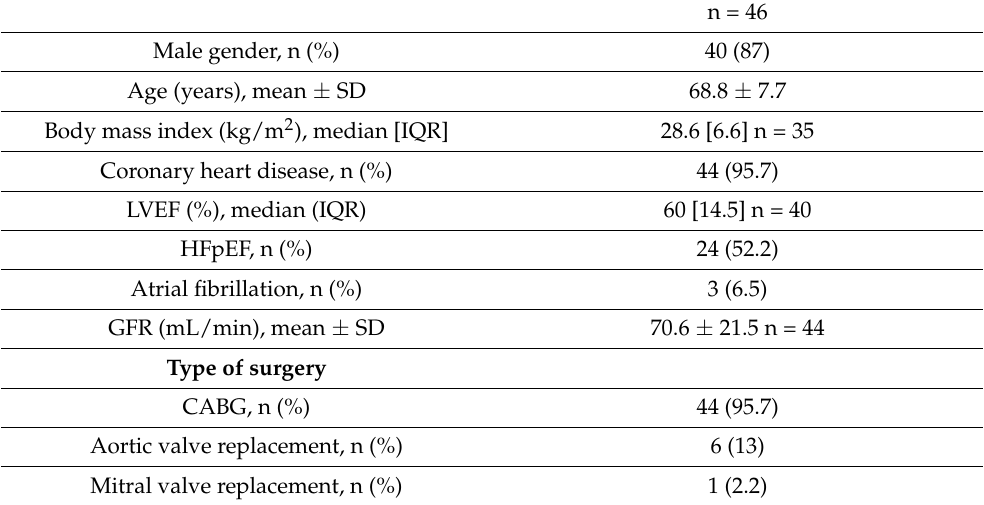
Table 1. Baseline patient